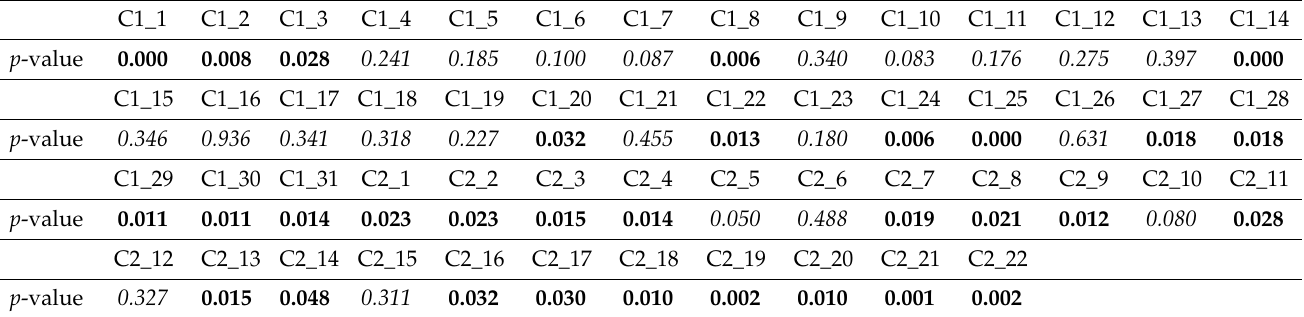
Table 3. p -values obtained for the Augmented Dickey–Fuller test.